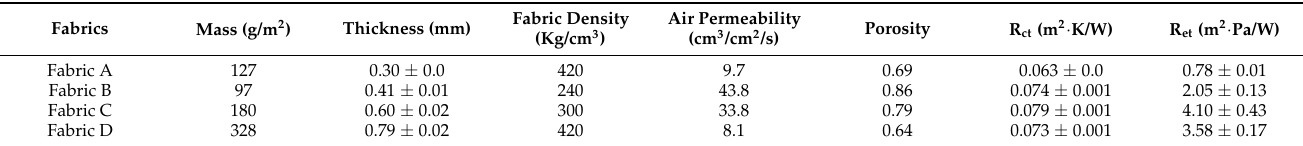
Table 2. Physical properties of the